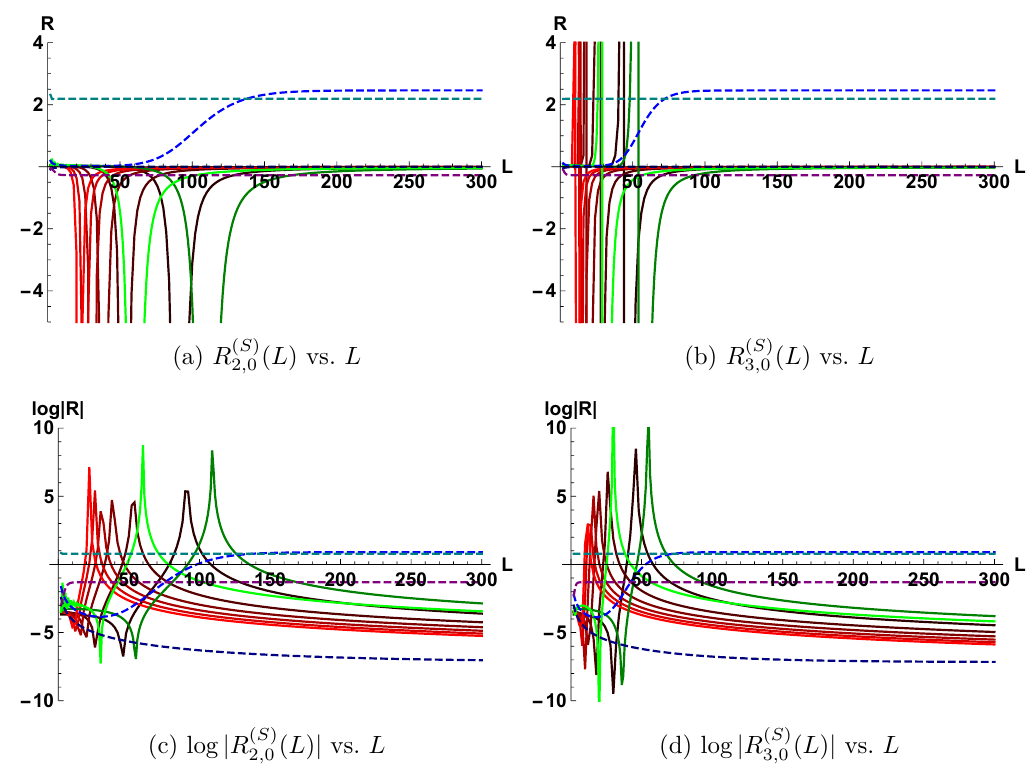
Figure 12. Current multipole ratios R ( S ) ( L ) .For the legend, see figure 6. The log plot below i, 0 shows the “peak” structure. The double peak structure is the result of one multipole moment that is exceptionally